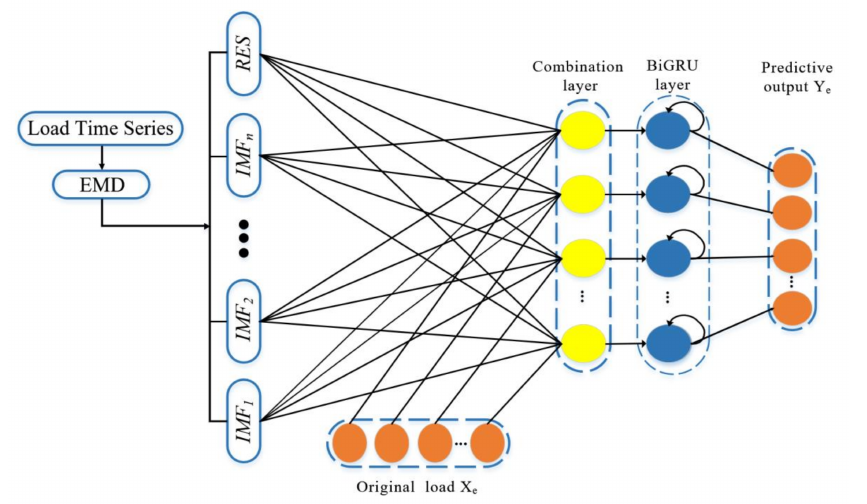
Figure 4. Flow chart of EMD-BiGRU